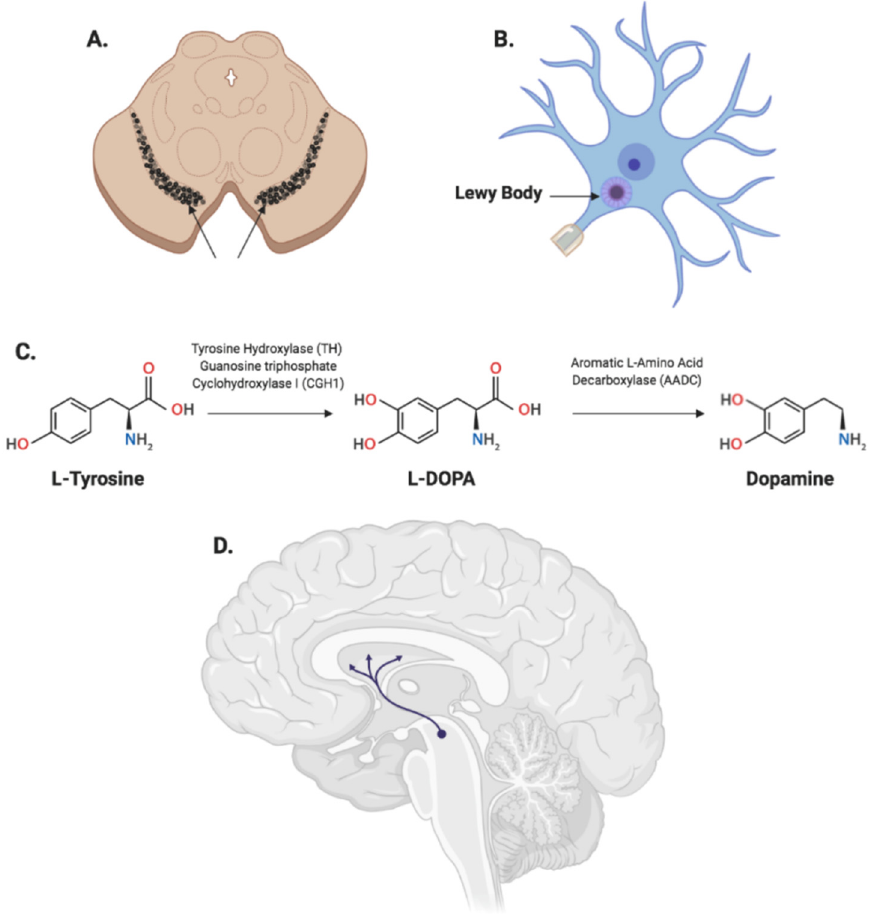
Figure 1. Neuro-pathophysiology of Parkinson’s disease. ( A ) Substantia nigra (black substance): patients in late stages of Parkinson’s disease (PD) lose more than half of the dopaminergic neurons in this region. ( B ) Intracellular Lewy body inclusions in dopaminergic neurons, a characteristic hallmark sign of PD. ( C ) Dopamine is obtained from diet-derived L-tyrosine; L-tyrosine is catalyzed to produce L-DOPA by tyrosine hydroxylase (TH) and guanosine triphosphate cyclohydroxylase I (CGH1), which is in turn decarboxylated to dopamine by aromatic l-amino acid decarboxylase (AADC). ( D ) Nigrostriatal pathway: connects nigral neurons to the striatum and aids with dopamine transport within the basal ganglia.